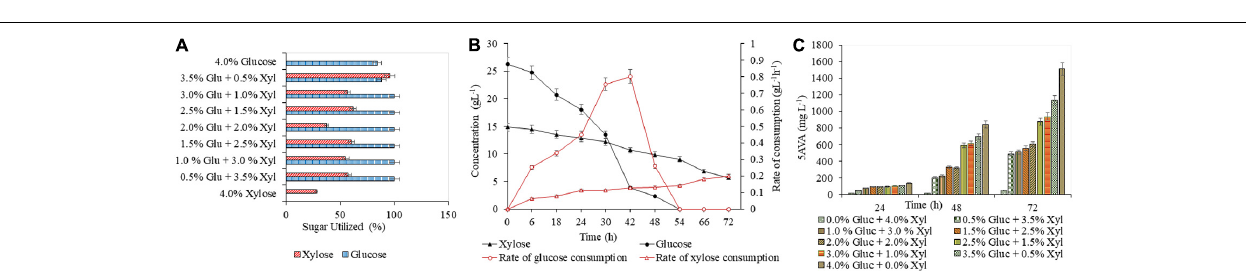
FIGURE 4 | Production of 5-AVA in CGXII medium with different blends of glucose and xylose. The utilization of glucose and xylose by PUT Xyl is shown in (A) . The glucose and xylose consumption rate of AVA Xyl is shown in (B) . The time profile of the 5-AVA production is shown in (C) . Measurements are given as means from triplicates of independent cultivations with standard